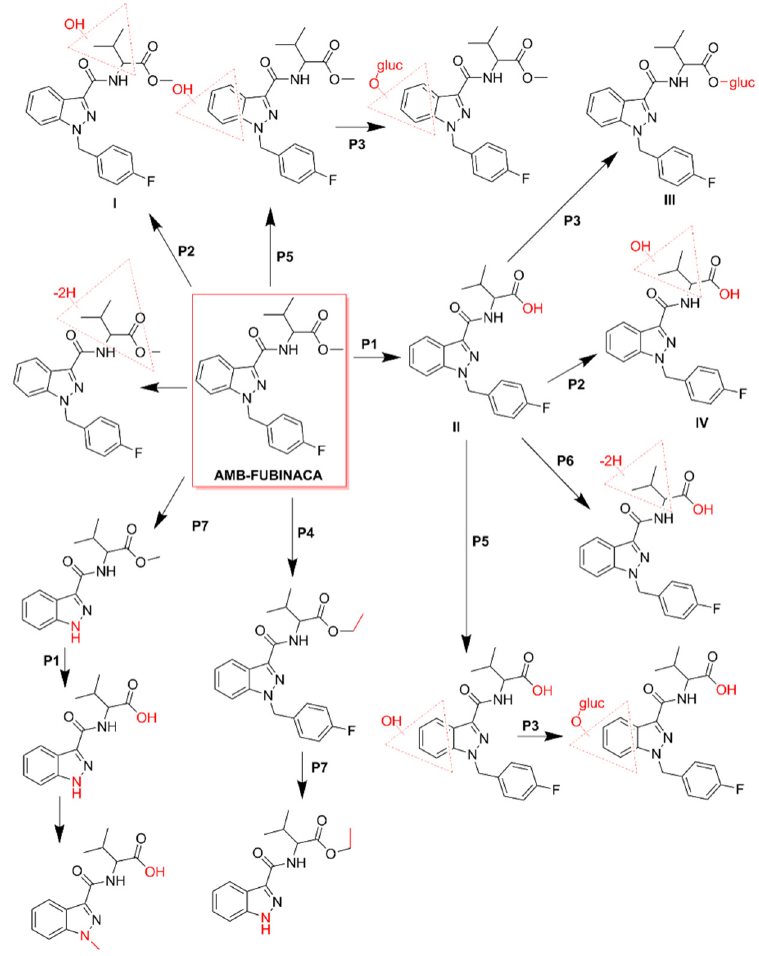
Figure 4. Metabolic pathways of AMB-FUBINACA [45]. The main biotransformation pathways include ester hydrolysis (P1), hydroxylation (P2), and glucuronide conjugation (P3). Methylation (P4), hydroxylation of the indazole ring (P5), dehydrogenation (P6), and N -dealkylation (P7) are also displayed. Dashed red triangles represent the location at which the reaction supposedly occurs.